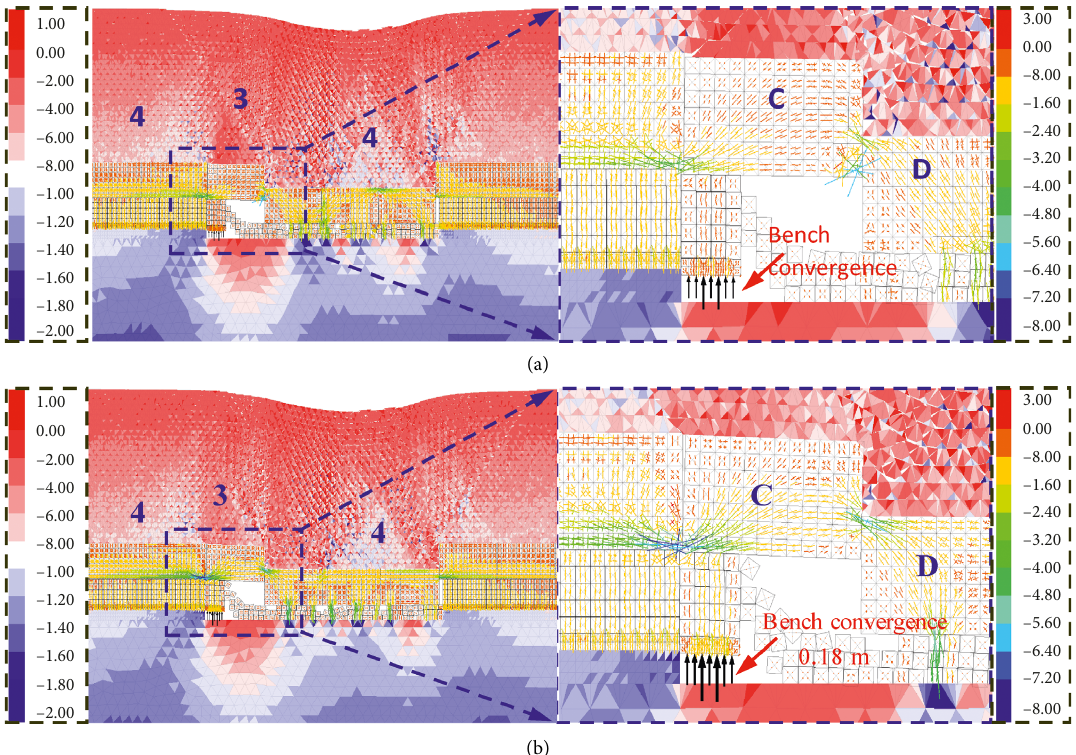
Figure 5: Stope stress distribution during the periodic weighting: (a) supporting intensity 0.8MPa and (b) supporting intensity 1.2MPa.